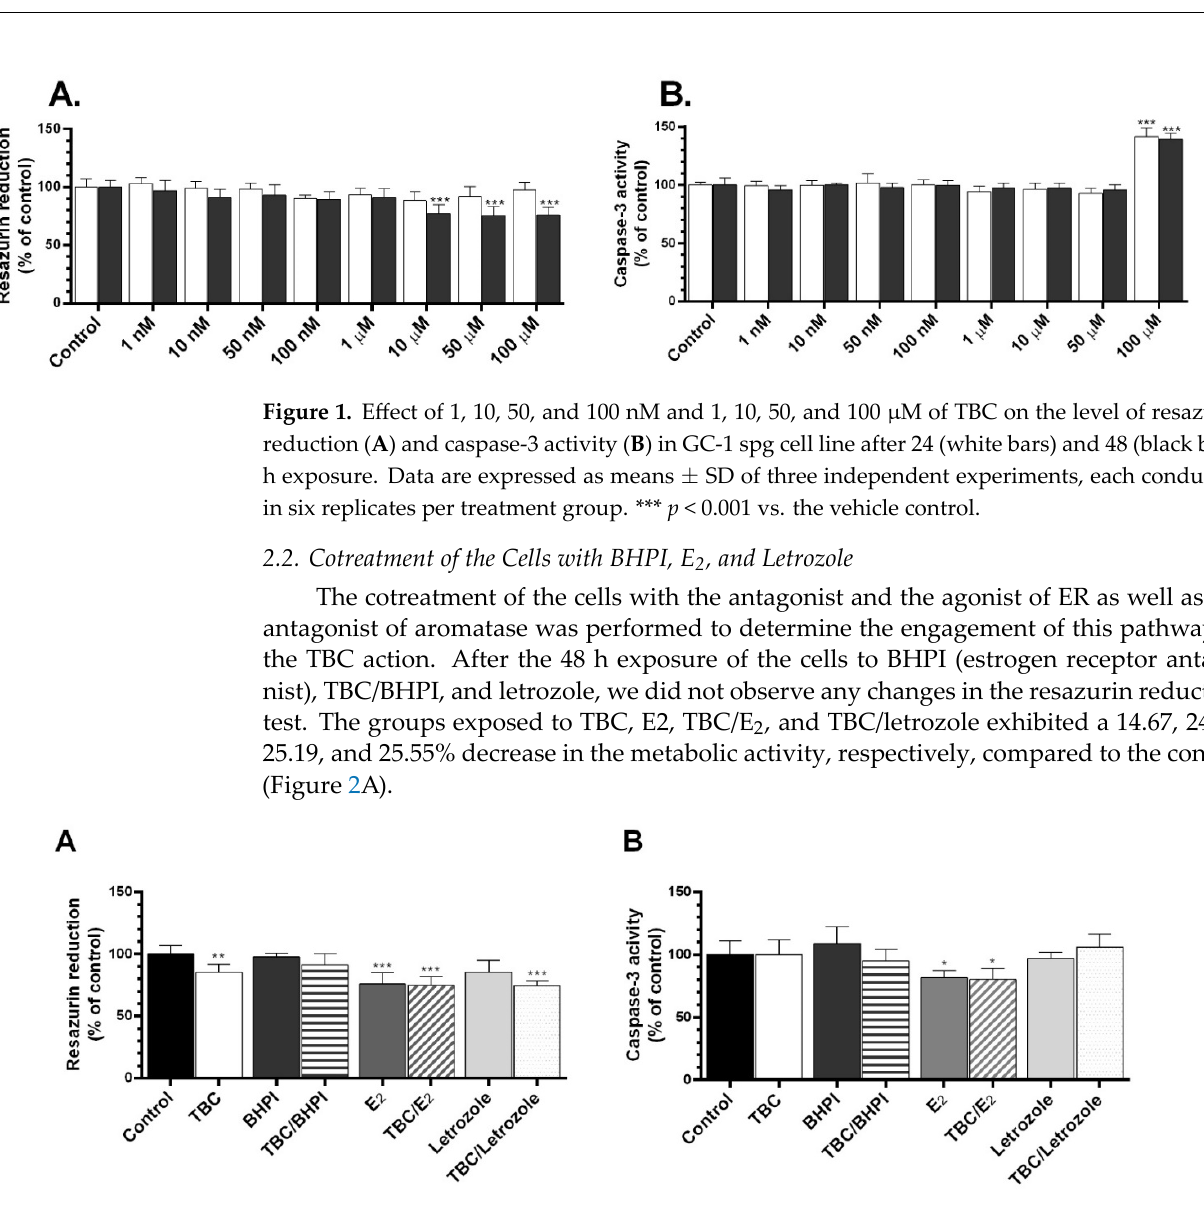
Figure 2. Effect of 10 µM of TBC and TBC in the cotreatment (BHPI—10 µM, E 2 —100 nM, letrozole— 1 µM) on the level of resazurin reduction ( A ) and caspase-3 activity ( B ) in the GC-1 spg cell line after 48 h exposure. Data are expressed as means ± SD of three independent experiments, each conducted in six replicates per treatment group. * p < 0.05, ** p < 0.01, *** p < 0.001 vs. the vehicle control